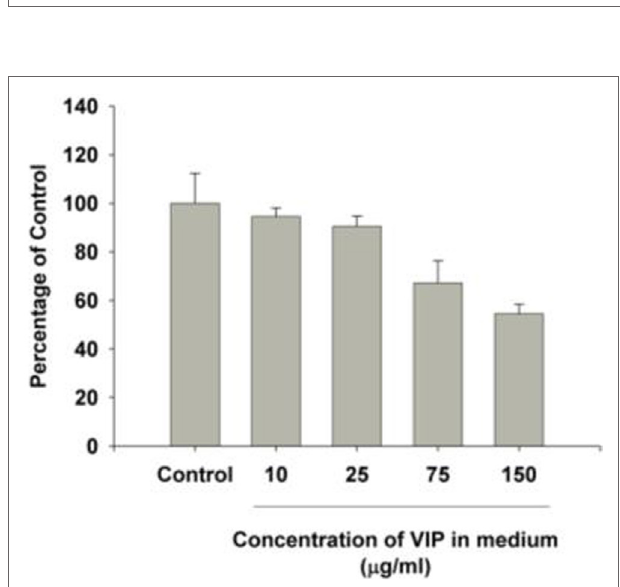
FigUre 3 | Vasoactive intestinal peptide (VIP) concentration-dependent changes to bladder cancer cell count in vitro. The growth in each group was significantly different from control cells grown in the absence of VIP. p < 0.001 [multiple comparisons vs. control group (Holm–Šidak